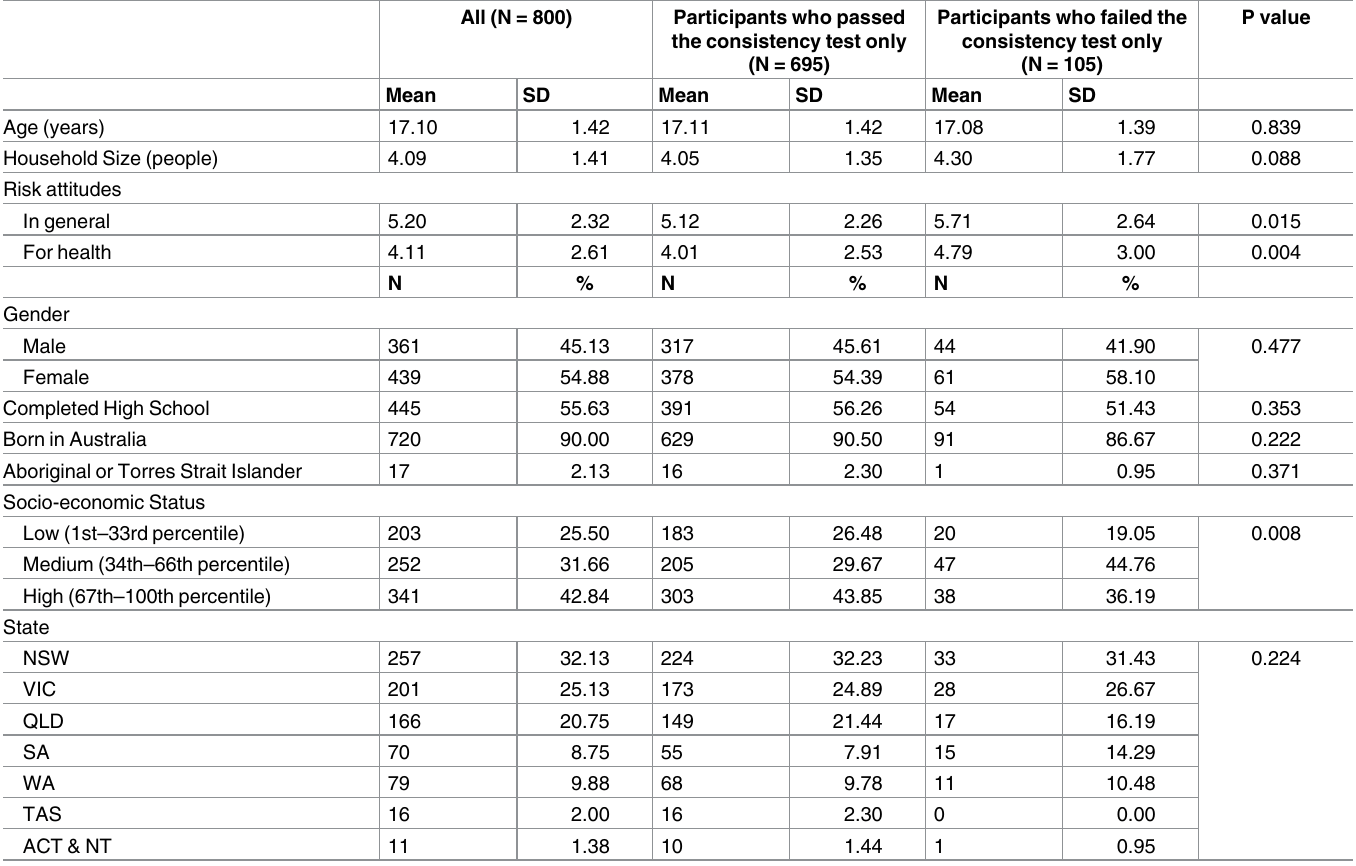
Table 2. Demographic characteristics of the study